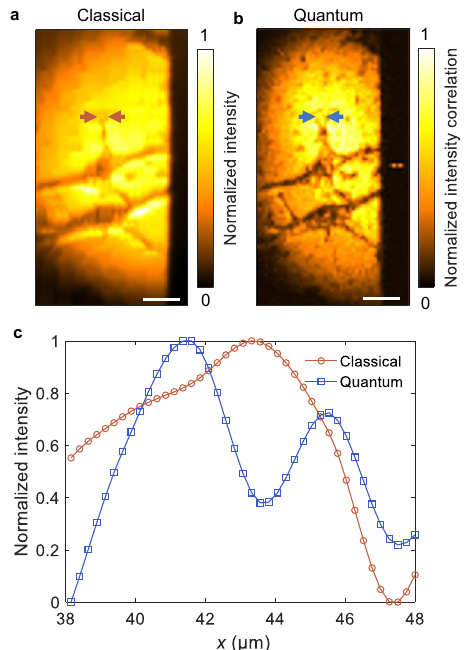
Fig.4|ImagingofcancercellswithQMC. Classical( a )andQMC( b )imagesoftwo HeLa cells. Scale bars, 20 μ m. c Normalized classical and QMC intensities between the arrows in ( a ) and ( b